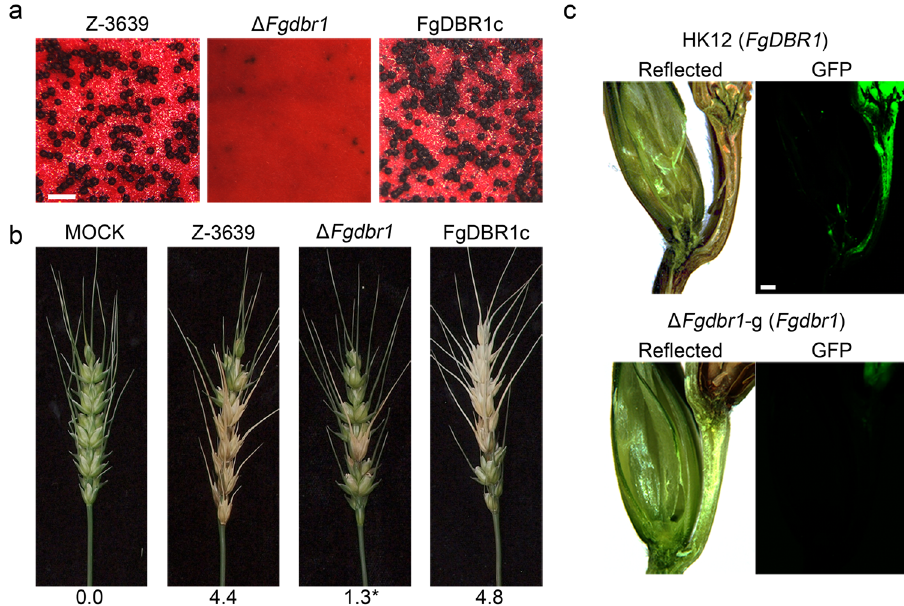
Fig. 3 Sexual development and virulence of F . graminearum strains. a Sexual development on carrot agar medium. A 5-day-old culture in carrot agar was mock fertilized to induce sexual reproduction. Pictures were taken 7 days after sexual induction. Scale bar = 500 μ m. b Virulence on wheat heads. The center spikelet of each wheat head was injected with 10 μ l of conidial suspension. The pictures were taken 21 days after inoculation. The diseased index (diseased spikelets per wheat head) is denoted below the picture and the asterisks indicate signi fi cant difference with p < 0.05. Mock, mock inoculation was performed with 0.01% Tween 20. n = 15 and n = 10 independently inoculated spikelets for wild type and mutant strains, respectively. c Micrographs of manually generated sections after infection of wheat. Wheat spikelets were inoculated with conidial suspensions of cytosolic GFP-expressing strains (HK12 and Δ Fgdbr1 -g) Infected wheat heads were longitudinally dissected at 6 days after inoculation and observed by fl uorescence microscopy. GFP fl uorescence signal indicates spreading of hyphae from the inoculation points. Arrowheads represent the inoculated spikelets. Re fl ected, bright fi eld image. Scale bar = 500 μ